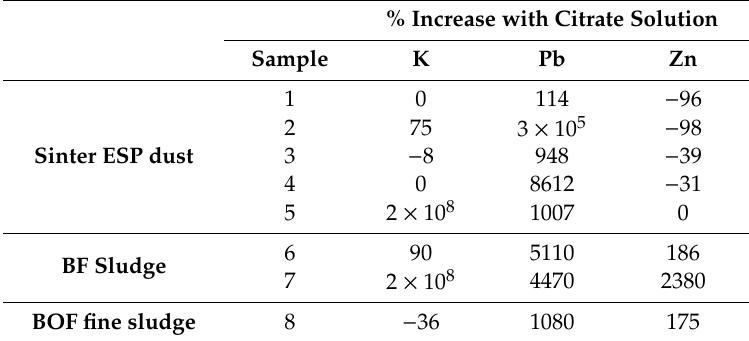
Table 1. Percentage increase* in key constituents K, Pb and Zn, after citrate leaching. % Increase with Citrate Solution